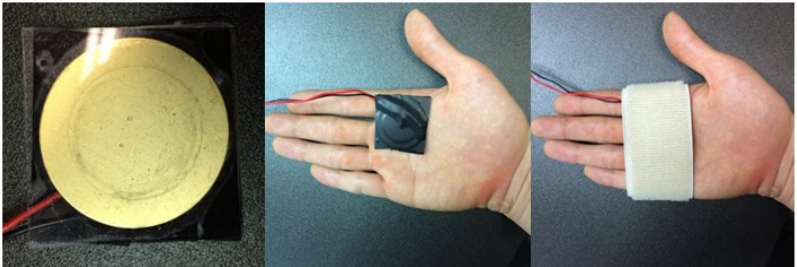
Figure 15. Haptic feedback device setup: a piezoelectric actuator glued on a transparent plastic panel ( Left ) and its attachment to the user’s hand with an elastic bandage.